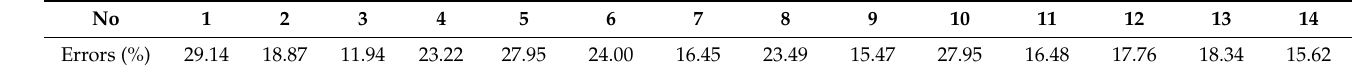
Table 2. The error of the estimated pelvis displacement by